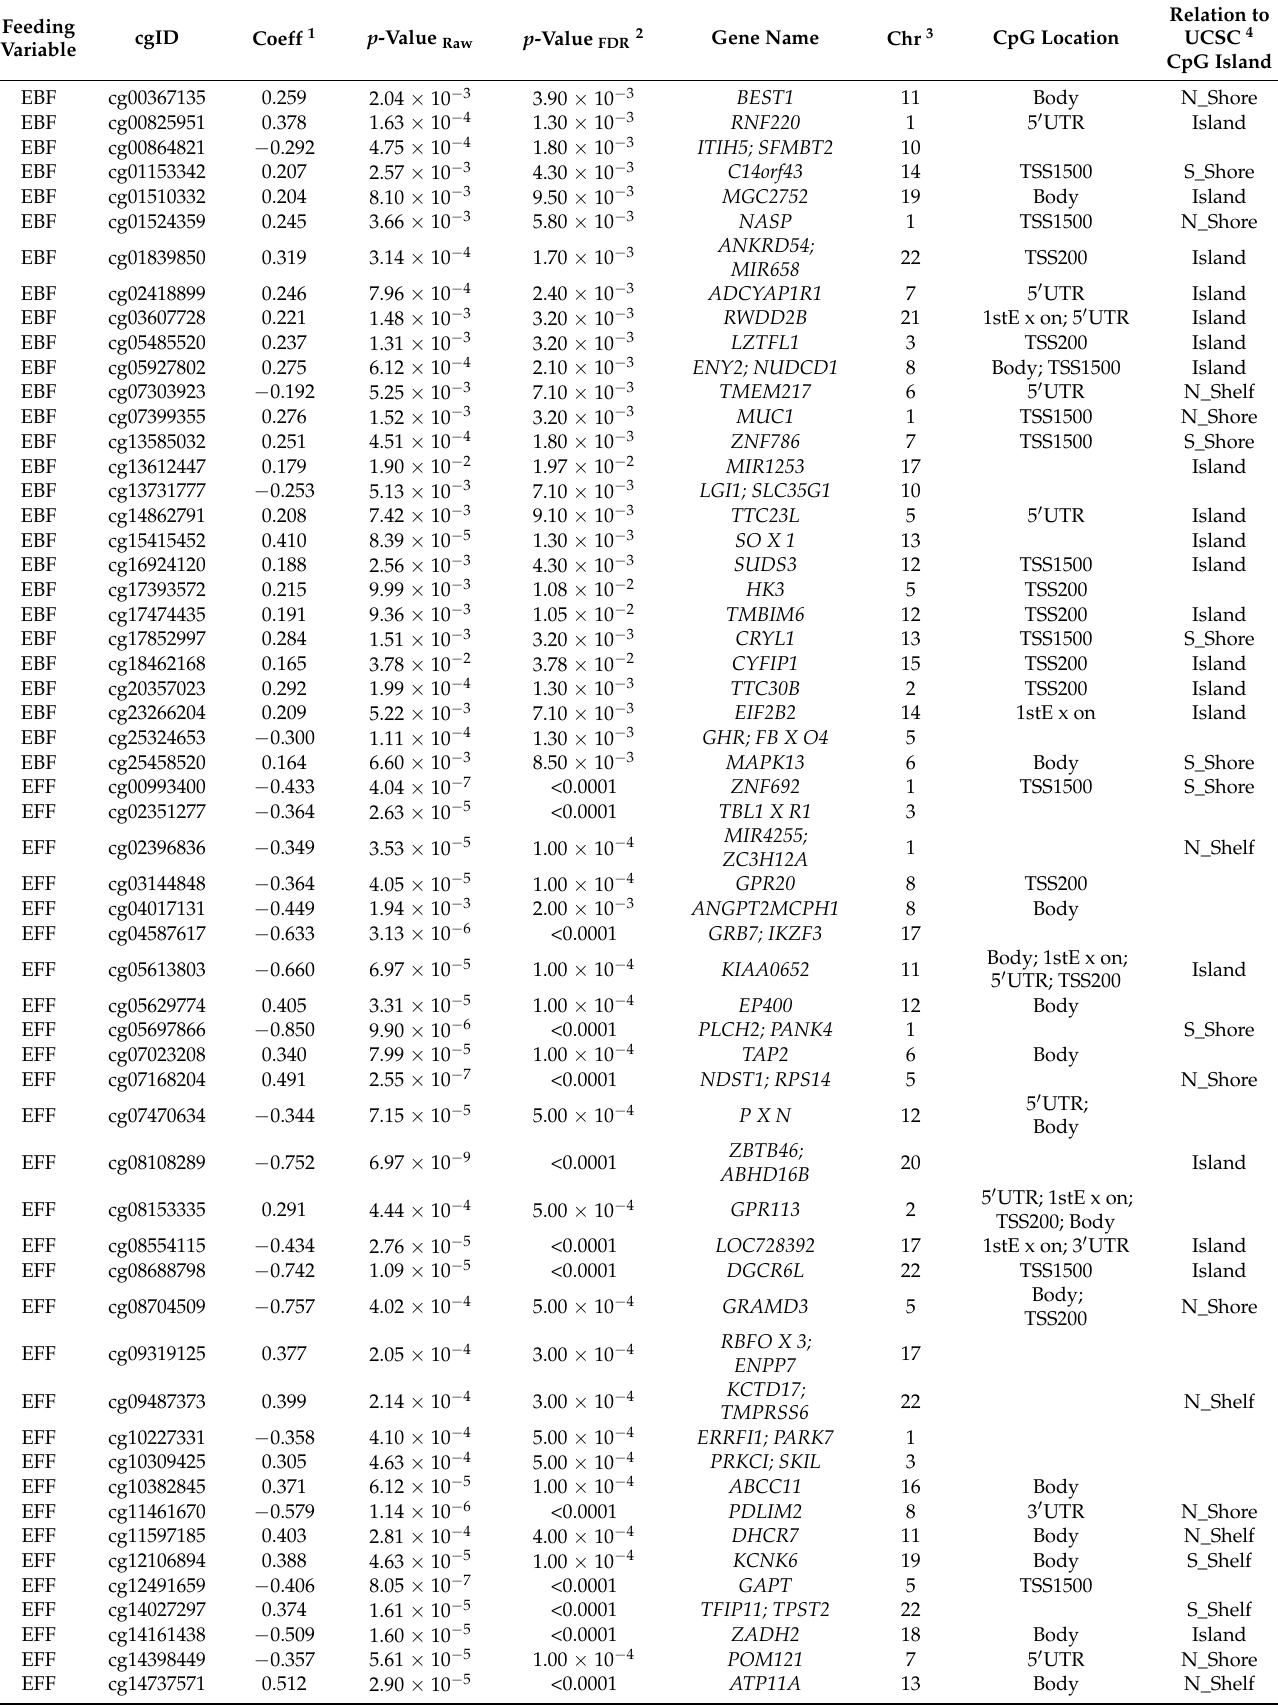
Table 2. List of CpGs significantly associated with the different modes of infant